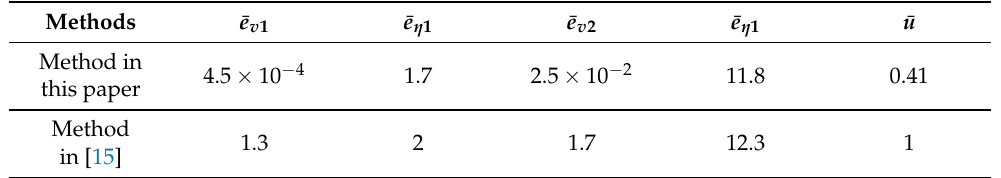
Figure 11. The estimation of domain of attraction Γ with different fault parameter in this paper. Table 1. Amplitude comparison of errors and control laws. ( e v 1 and e η 1 are amplitude of velocity errors position errors at the final moment; e v 2 and e η 2 are amplitude of velocity errors position errors in the process of fluctuation; ¯ u is amplitude of u in the adjustment process.).